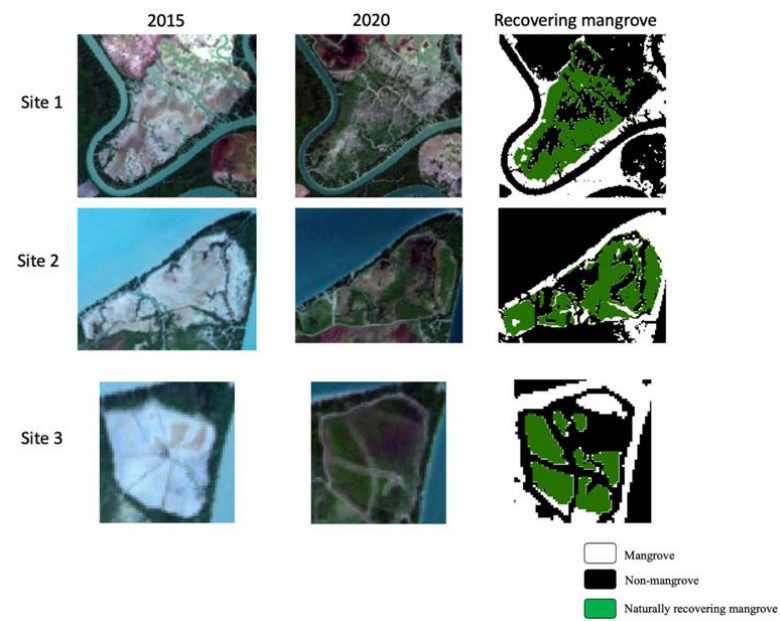
Figure 16. Naturally recovering mangrove at different abandoned sites between 2015 and 2020. Table 6. Naturally recovering percentage of mangrove at different abandoned shrimp ponds. Remote Sens. 2021 , 13 , x FOR PEER REVIEW